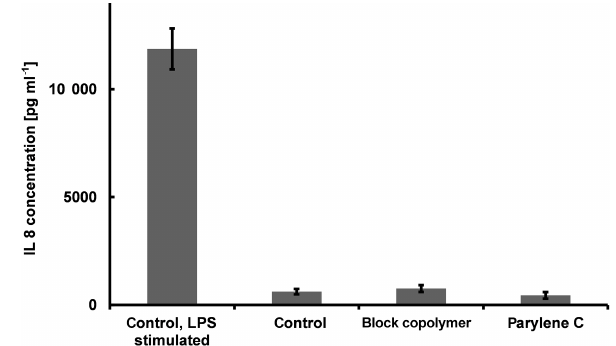
Figure 11. IL8 expression of human fibroblasts after the incubation on parylene C, on the block copolymer as well as on the control materials ( n =